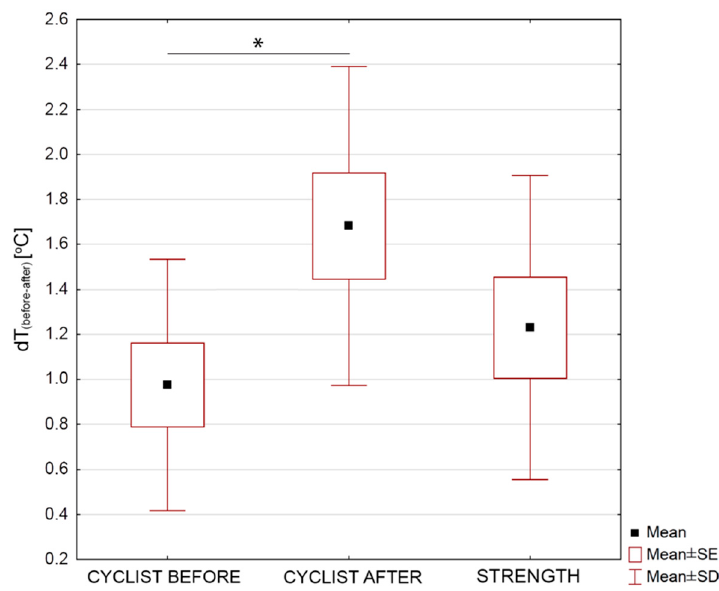
Figure 7. Body surface temperature coefficient dT (before-after) (defined as body temperature before-body temperature after training) difference for all studied groups: cycling sportspersons before and after one training year as well as strength sportspersons group. Statistically significant changes were marked as * on the graph with p < 0.05.